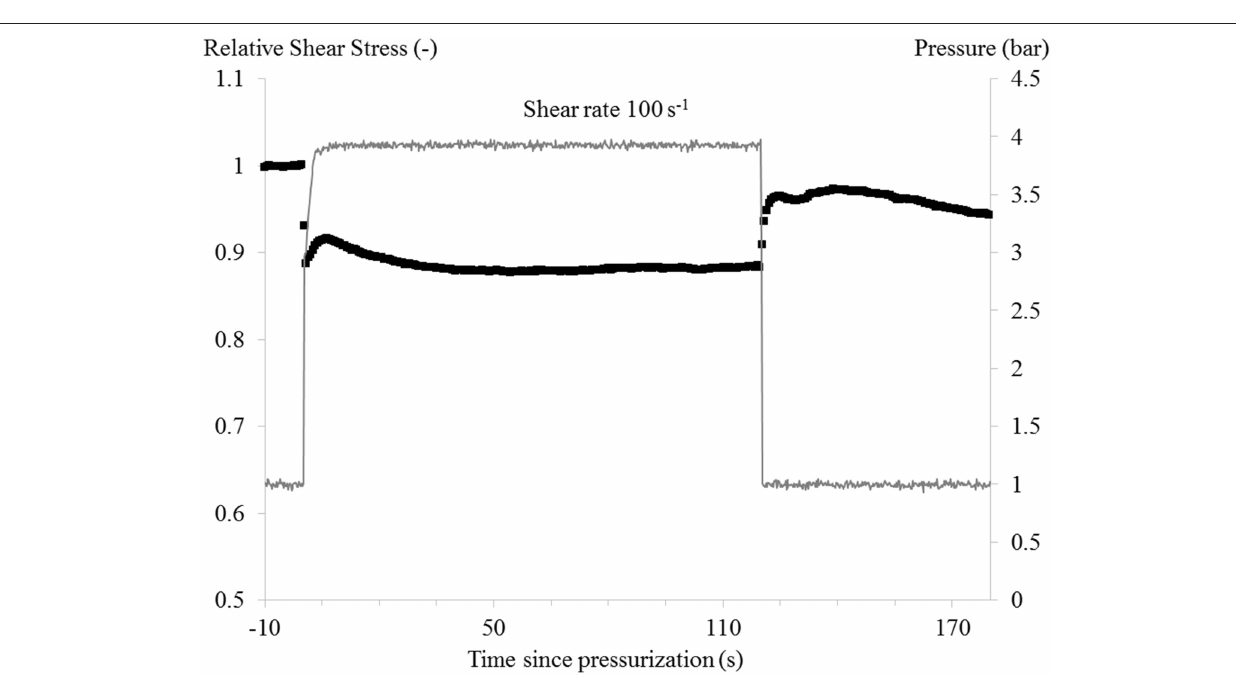
equal to 1 after depressurization, which may have several